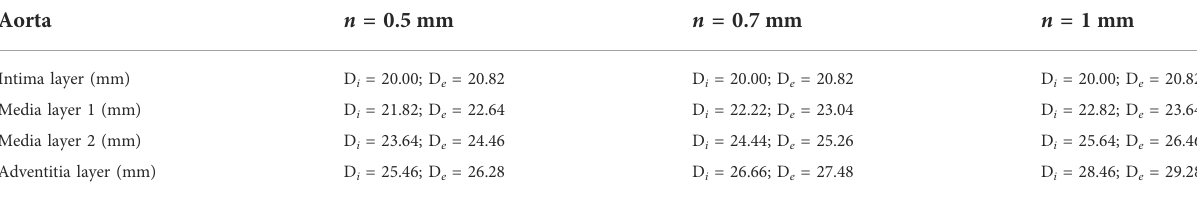
TABLE 2 Dimensions of the internal (Di) and external (De) diameter of each layer, as a function of the parameter n, the distance between the layers of the construct.